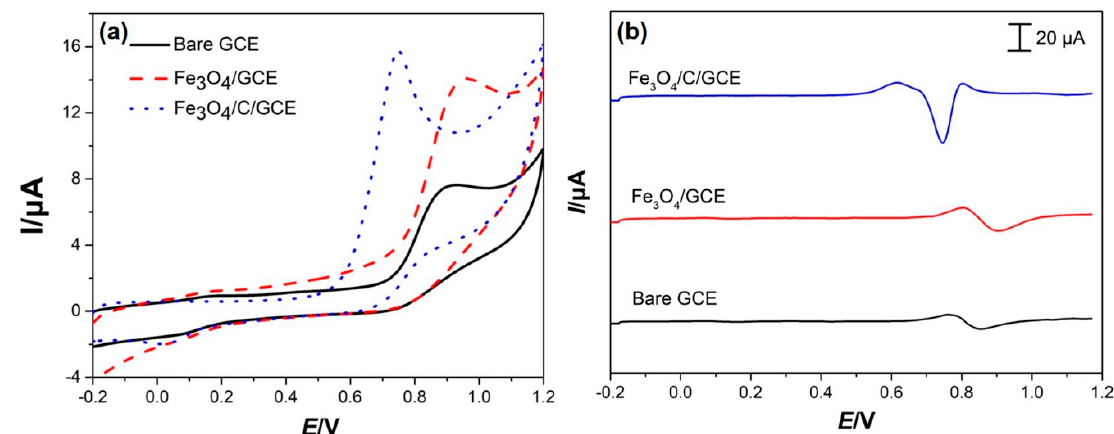
Figure 4. CV ( a ) and second derivative linear scan voltammetry (SDLSV) ( b ) responses of 10 μ M Trp on bare GCE, Fe 3 O 4 /GCE, and Fe 3 O 4 /C/GCE. Supporting electrolyte: 0.1 M PBS (pH 6.5); Scanning rate: 0.1 V/s.